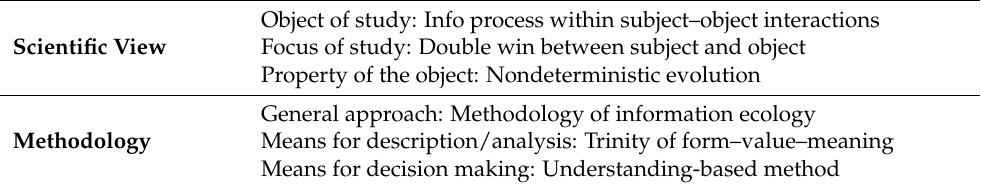
Table 3. Major features of the paradigm suitable for the information